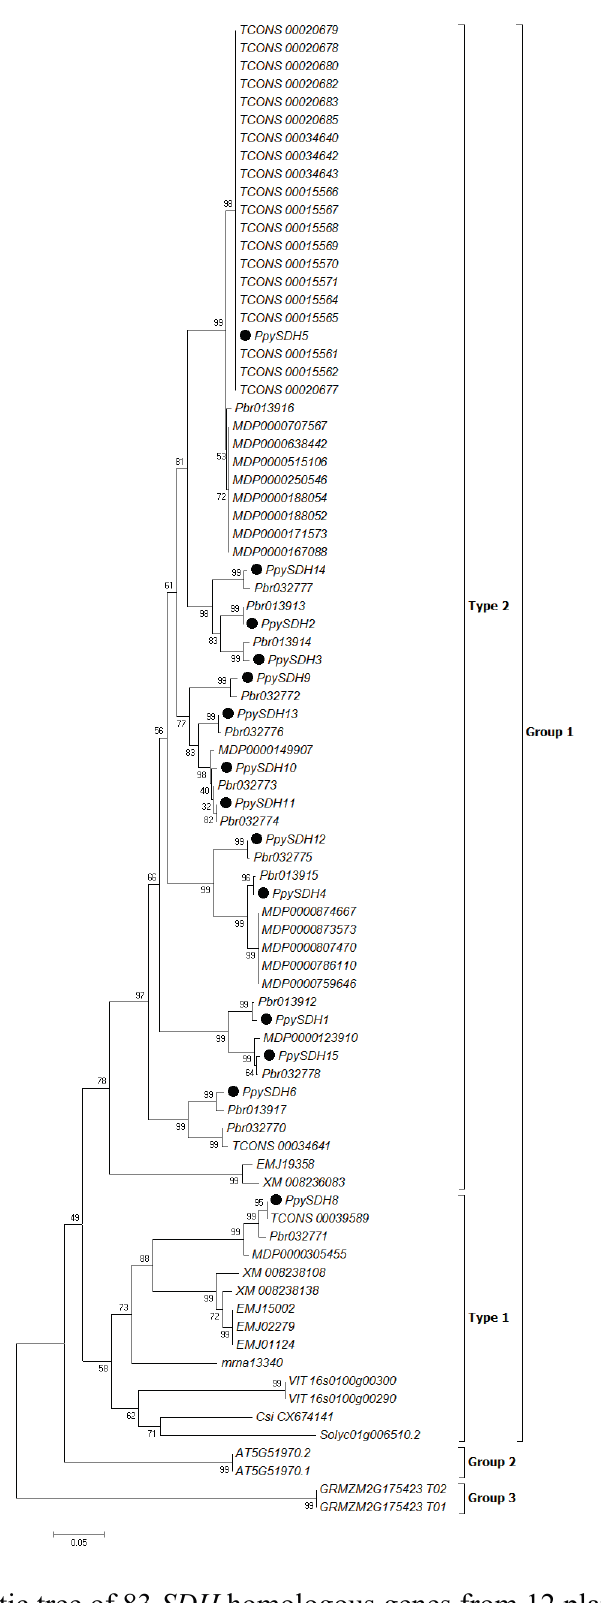
Figure 1. Phylogenetic tree of 83 SDH homologous genes from 12 plant species, including 14 PpySDH genes ( ● ) identified from the P. pyrifolia transcriptome. The phylogenetic tree was generated using the neighbor joining (NJ) method in Molecular Evolutionary Genetics Analysis version 6 (MEGA6) [19]. Numbers given at branch nodes are the bootstrap values of the confidence level, as percentages calculated from 1000 random